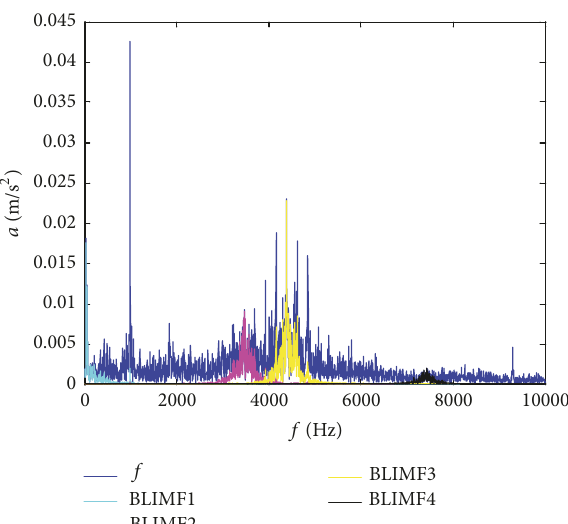
Figure 5: The BLIMFs and frequency spectrum of #600.